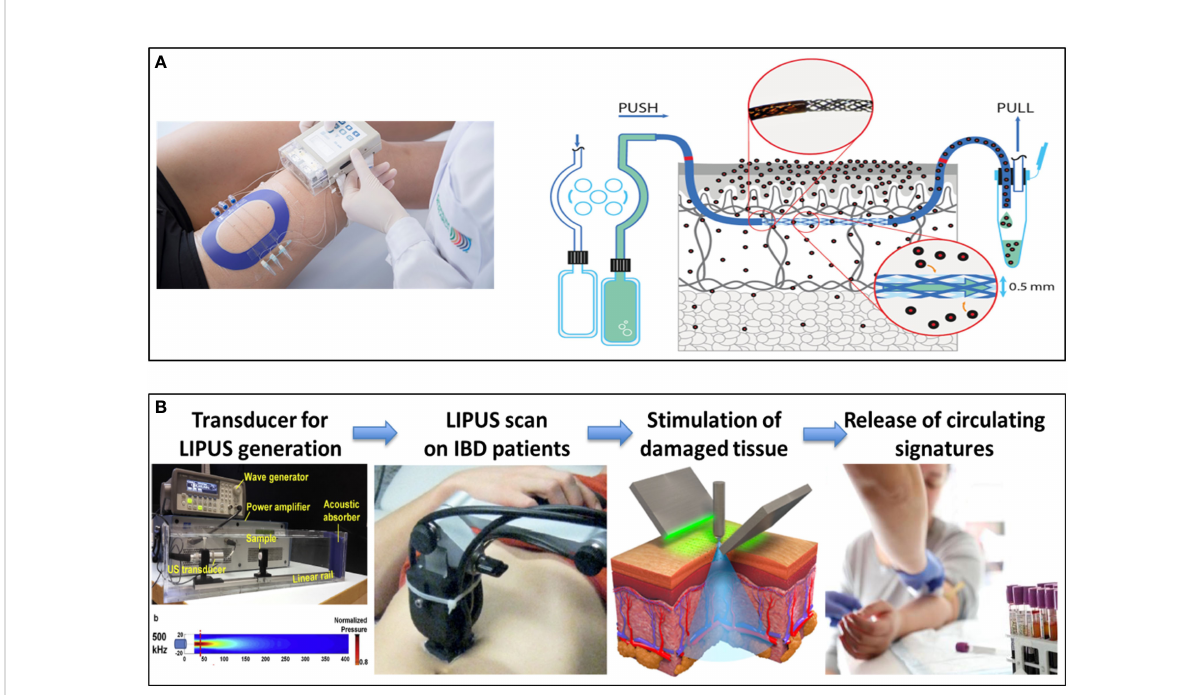
FIGURE 2 Development of new Disruptive liquid biopsy technologies. Schematic overview of dermal open- fl ow microperfusion (dOFM) (A) and